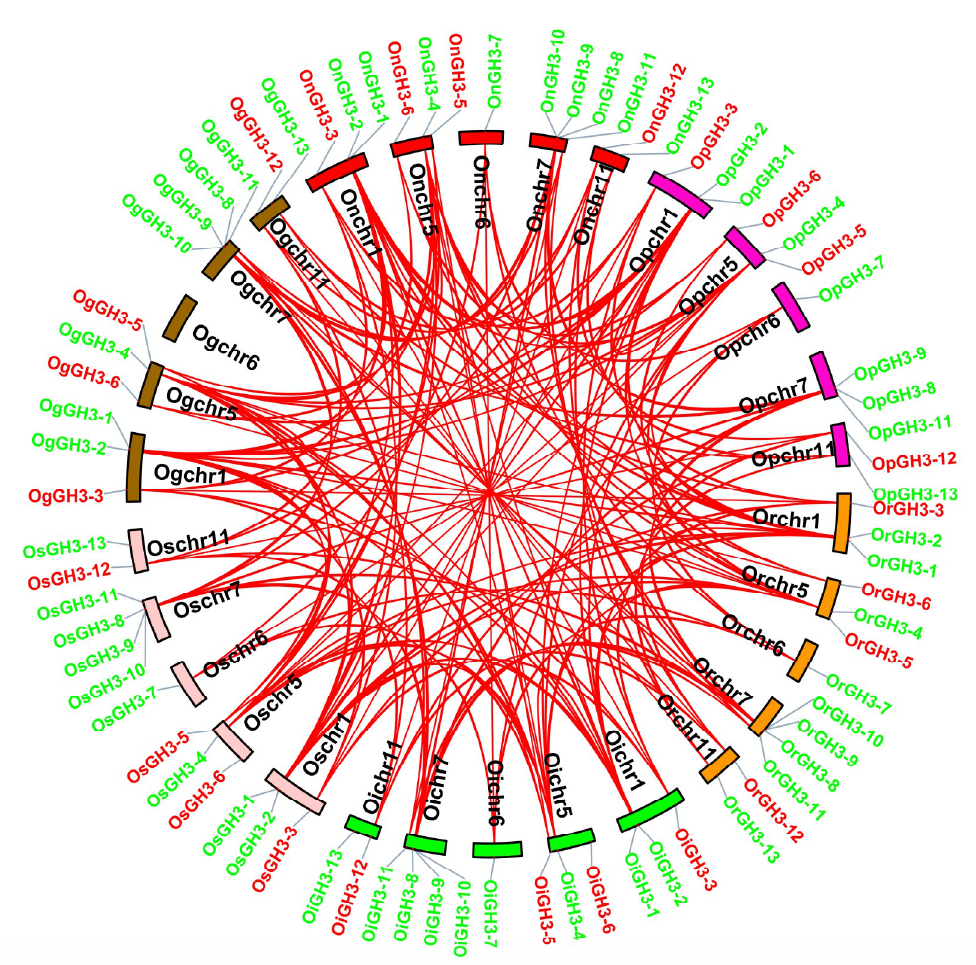
Figure 4. The collinear gene pairs across six Oryza species/subspecies. The chromosome colors and abbreviations of species are the same as in Figure 3. The red lines represent collinear gene pairs. Table 2. Ka, Ks, and Ka/Ks values for the duplication gene pairs from six Oryza species/subspecies. Seq1 Seq2 Ks Ka Ka/Ks ratio Date (MY)